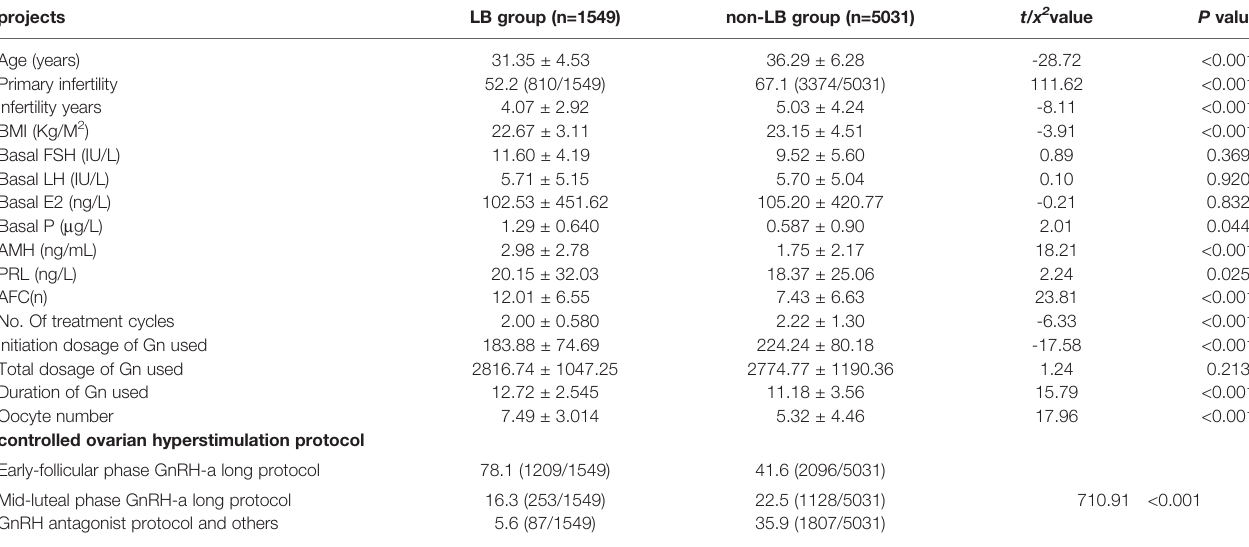
TABLE 1 | Baseline characteristics of patients with LB and non-LB and independent risk factors for the pregnancy results.